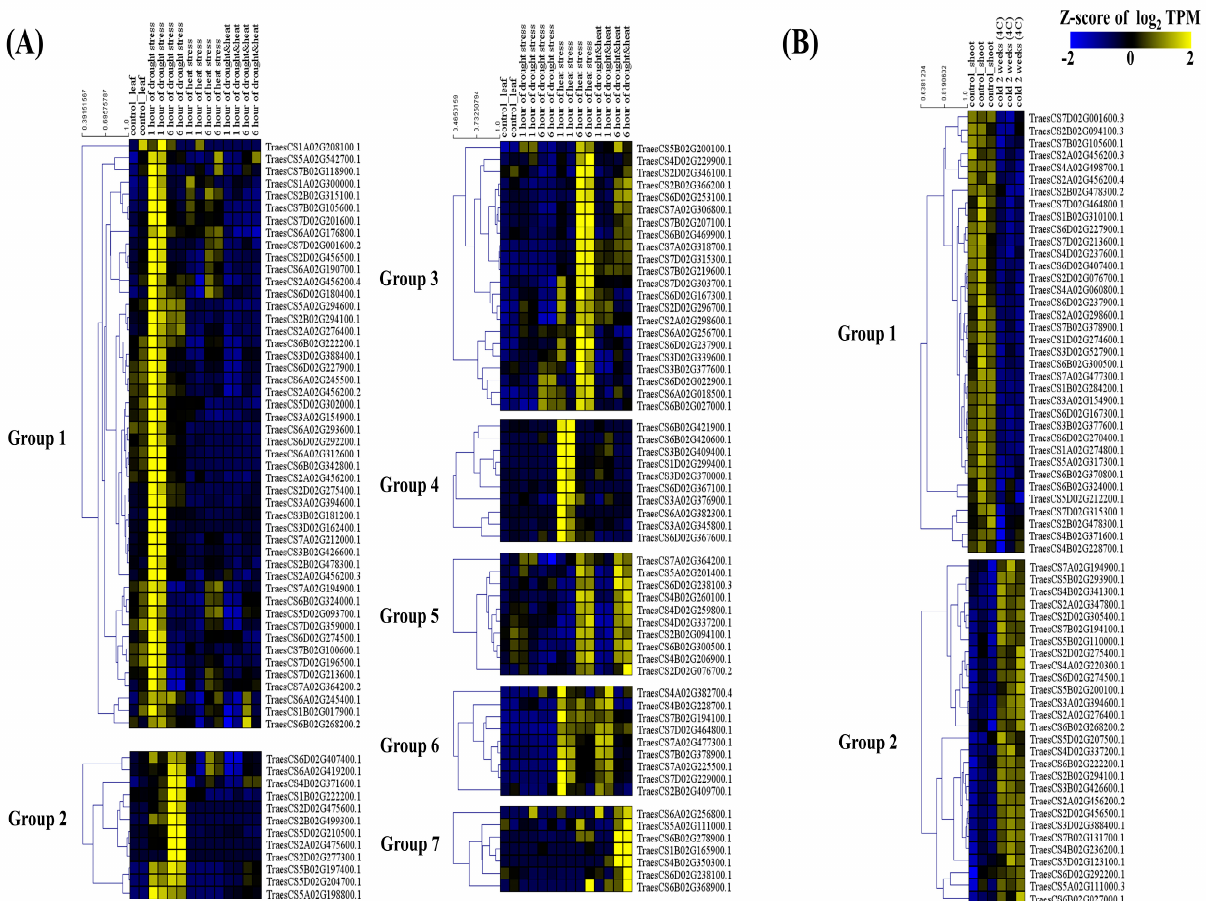
Figure 8. Expression profiling and classification of wheat U-box E3 genes under abiotic stress condition. The average log 2 transformed transcripts per million (TPM) values of U-box E3 genes classified into 7 and 2 sub − groups by K − means clustering methods under ( A ) drought, heat, and combined heat and drought stress conditions, and ( B ) cold stress conditions, respectively.